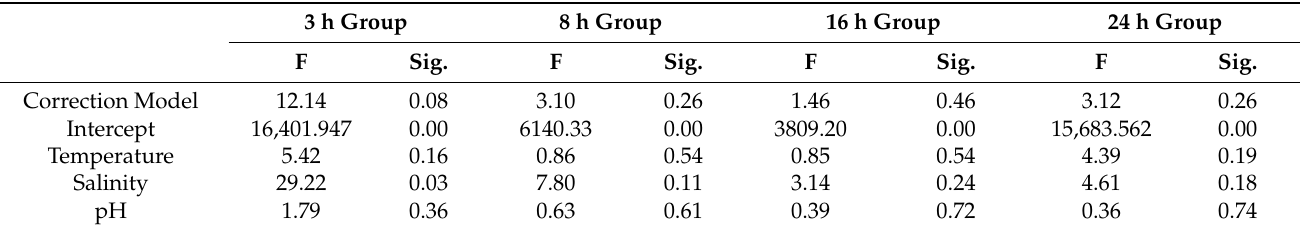
Table 6. ANOVA results for the orthogonal experiment (3–24 h).